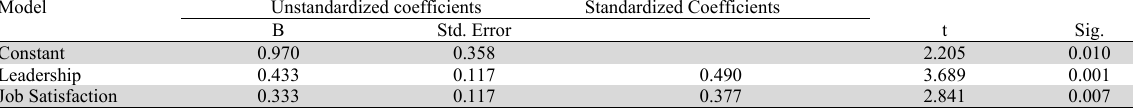
Results of Path Coefficient Test of Leadership and Job Satisfaction on Performance Model